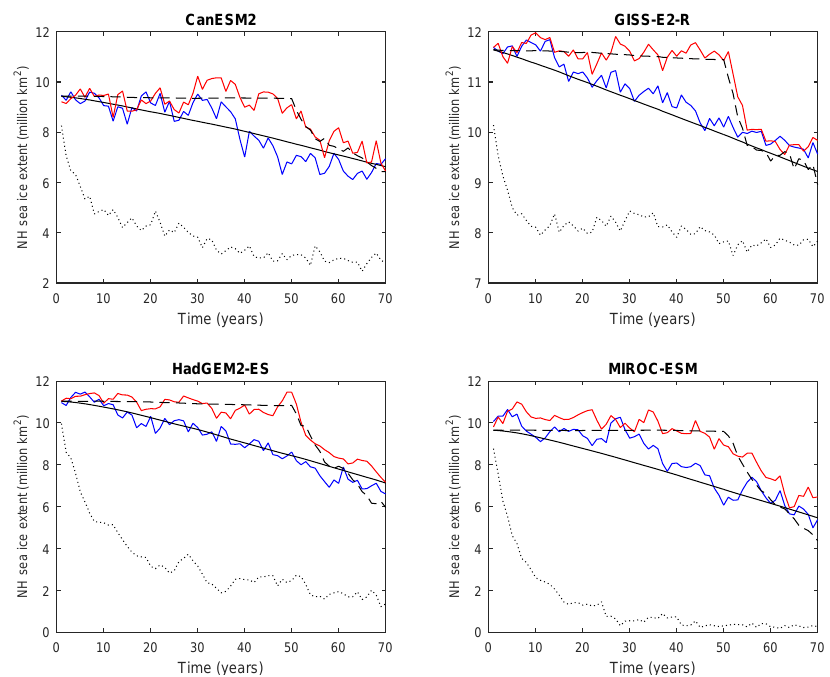
Figure 6. As in Fig. 3 but for Northern Hemisphere annual-mean sea ice extent. Simulated and emulated response are shown for 1% per year increase in CO 2 and GeoMIP experiment G2 for several of the climate models considered here; the dotted line shows the response for the abrupt 4 × CO 2 simulation.